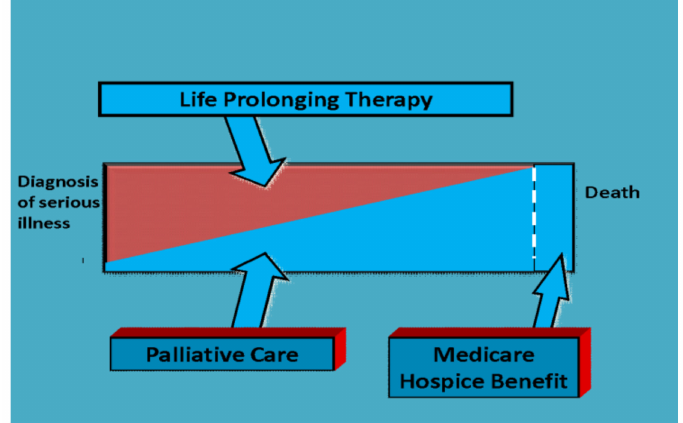
Figure 1. Palliative Medicine’s Role during Illness. Adapted from “the integrated model of care” proposed by the World Health Organization in 1990